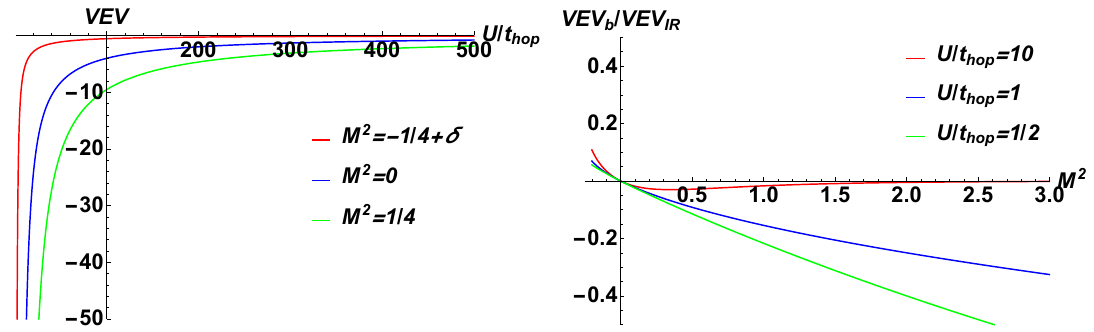
Figure 4 . With varying M and for any (cid:26) , the normalized VEV of the bi-fundamental is plotted as a function of U=t hop for (cid:12)xed u h = U = 10, w = (cid:21) = 1, and (cid:3) ( p;r ) = 0. Now, (cid:3) is speci(cid:12)ed to be 1, and the IR boundary condition is (3.5) in the homogeneous phase. Left: (cid:14) is a small positive parameter. The absolute value of the VEV increases as M 2 increases. The VEV approaches 0